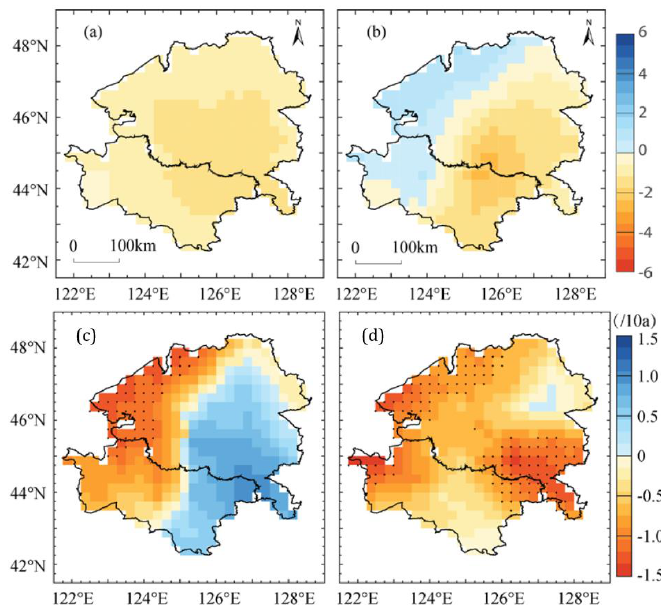
Figure 10. The 30-year average Palmer Drought Severity Index (PDSI) in 1901–1930 ( a ) and 1981–2010 ( b ), in which a negative value represents drier and a positive one means wetter conditions. In their 30-year linear trends in 1901–1930 ( c ) and 1981–2010 ( d ), black dots mark the grids with significant